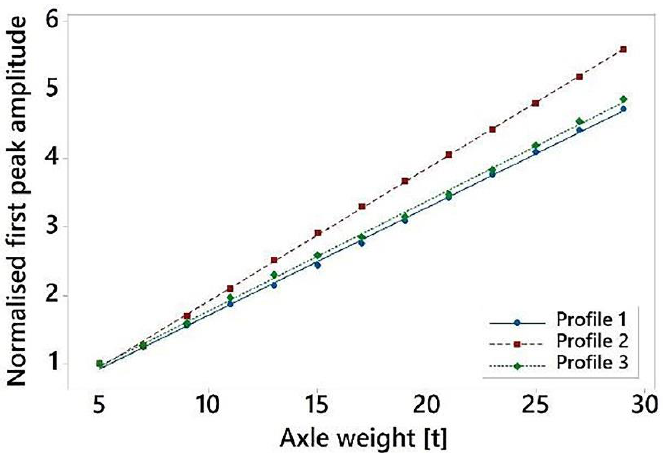
Figure 3. Relationship between axle mass and normalised 1st peak amplitude for 3 different profiles.